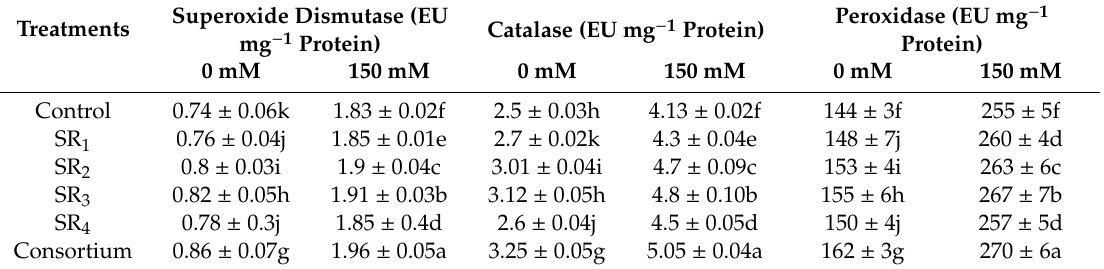
Table 7. E ff ects of halotolerant PGPR on the antioxidant enzymes activity of wheat plants grown under salinity